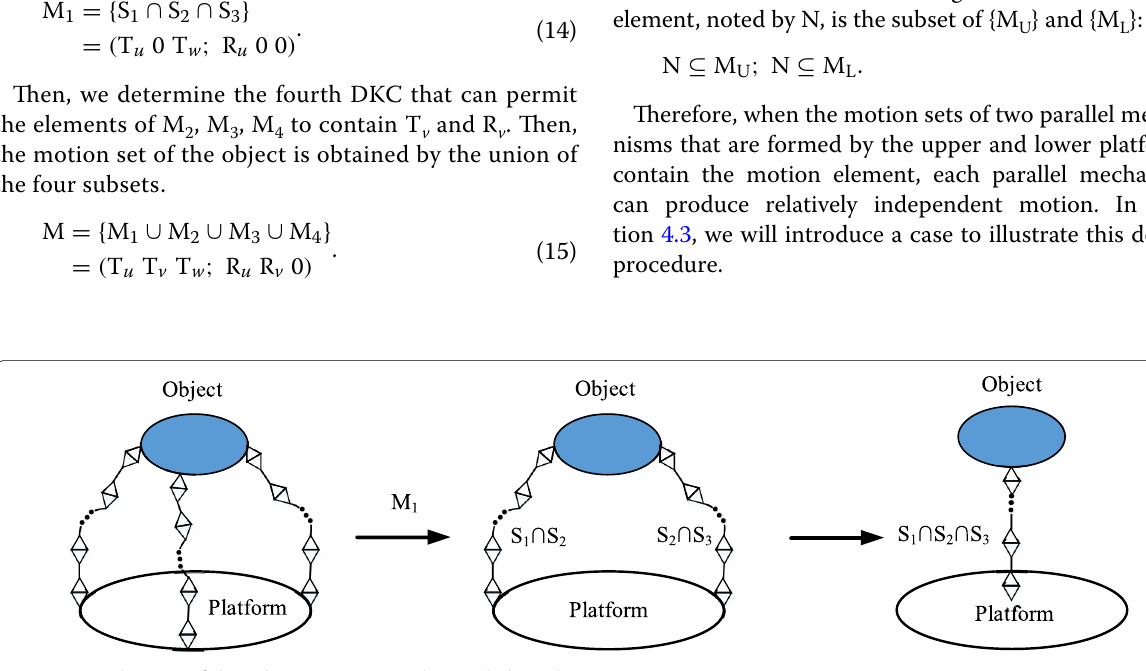
Figure 12 Schematic of chain decomposition topology with three